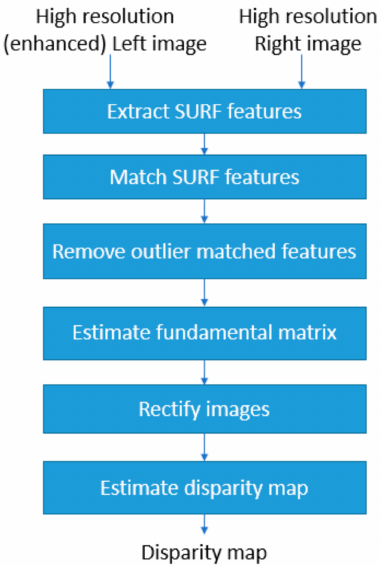
Figure 6. Processing steps of the disparity map